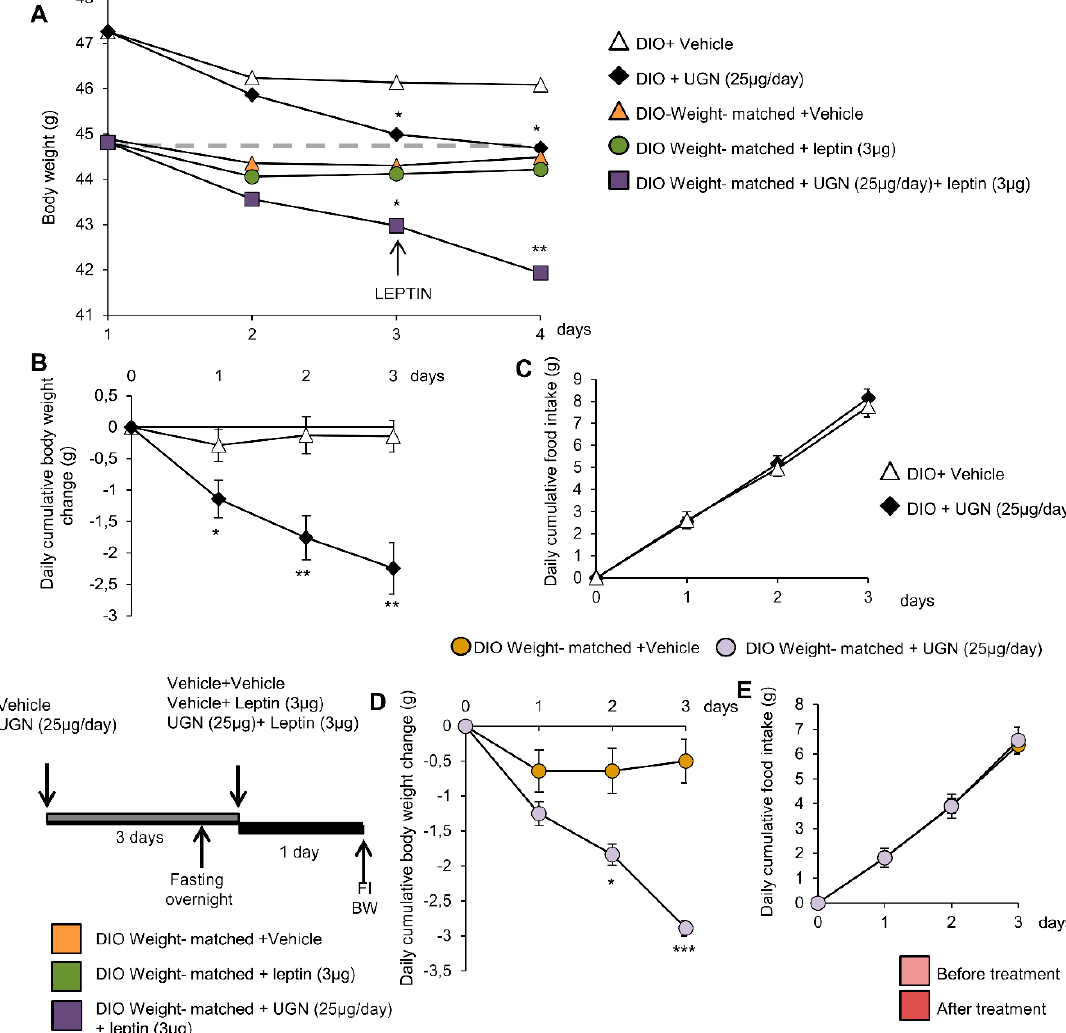
Figure 5: Effect of chronic ICV UGN (25 μ g/mouse) injection for four days and ICV leptin (3 μ g/mouse) for 24 h in DIO mice and weight-matched DIO mice on body weight ( A ). Effect of chronic ICV saline or UGN (25 μ g/mouse) injection for three days on body weight change ( B ) and food intake (C) in DIO mice. Effect of chronic ICV saline or UGN (25 μ g/mouse) injection for three days on body